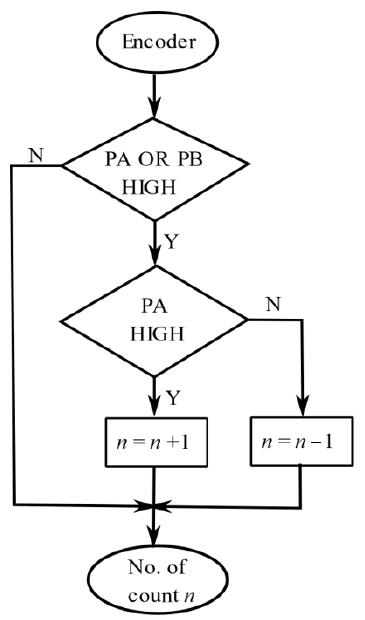
Figure 12. Pulse waveforms generated by the encoder: ( a ) forward motion; ( b ) backward motion.